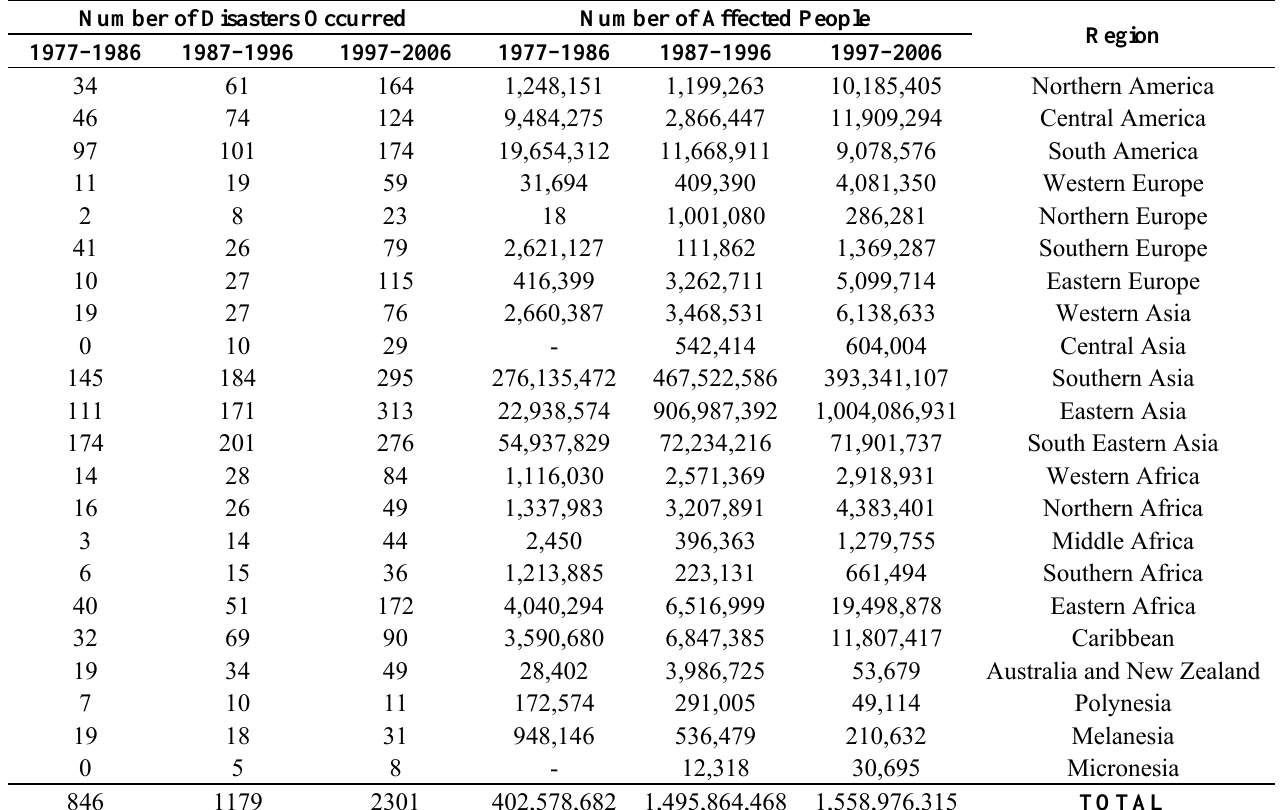
Table 1. Natural Disasters and Affected People by Regions